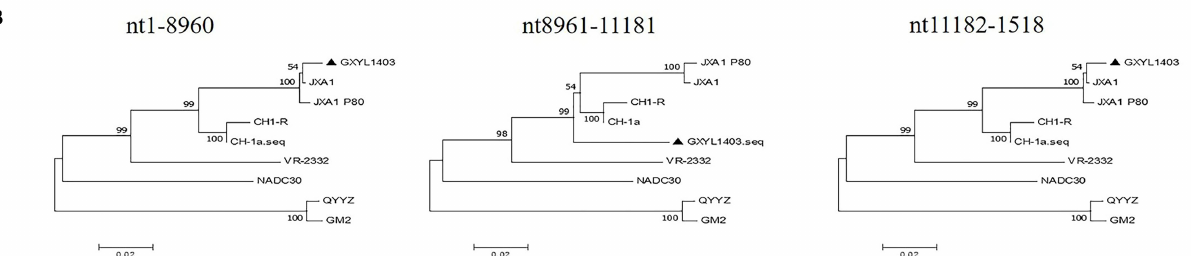
FIGURE 3 | Identification of potential recombination events in the genome of the GXYL1403 strain using RDP3.44. (A) Comparisons of genetic similarities between recombinant and parental strains were made by SimPlot. The complete genome of GXYL1403 was chosen as the query sequence. The y-axis indicates the percentage similarity between the parental sequences and the query sequence. The red real diagram indicates the recombination breakpoints. (B) Phylogenetic trees of different regions in the PRRSV GXYL1403 genome were analyzed by RDP3.44 with UPGMA parsimony. Three trees were generated by the recombinant region (position: nt8961–nt11181) and the non-recombinant regions (position: nt1–8960 and